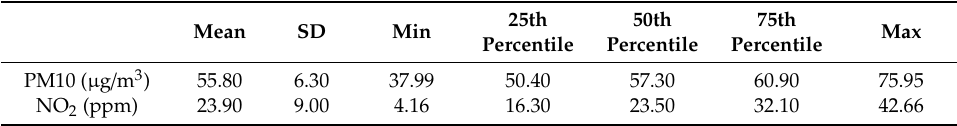
Table 1. The average exposure level of air pollutants in the past 5 years (2002–2007). 25th Mean SD Min Percentile